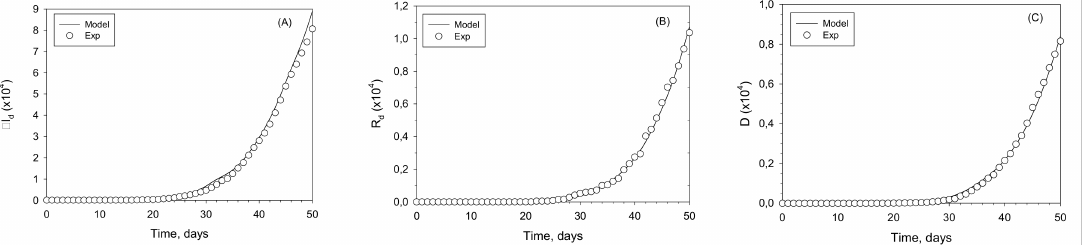
Figure 3. Infection units model fitted to Italy: ( A ) cumulative detected infected population, Σ I d ; ( B ) detected, recovered population, R d ; ( C ) dead population, D . Experimental data (cycles); modelled populations (continuous